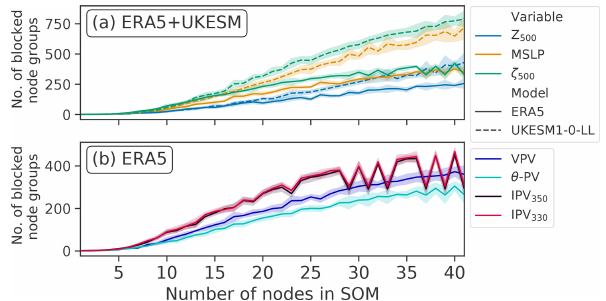
Figure 9. The number of node groups that are identified as blocked in the SOM-BI for ERA5 and UKESM for a range of node numbers and variables. The panels separate the variables available in both models from those only available in ERA5. Error bands show the standard deviation ( ± 1 σ